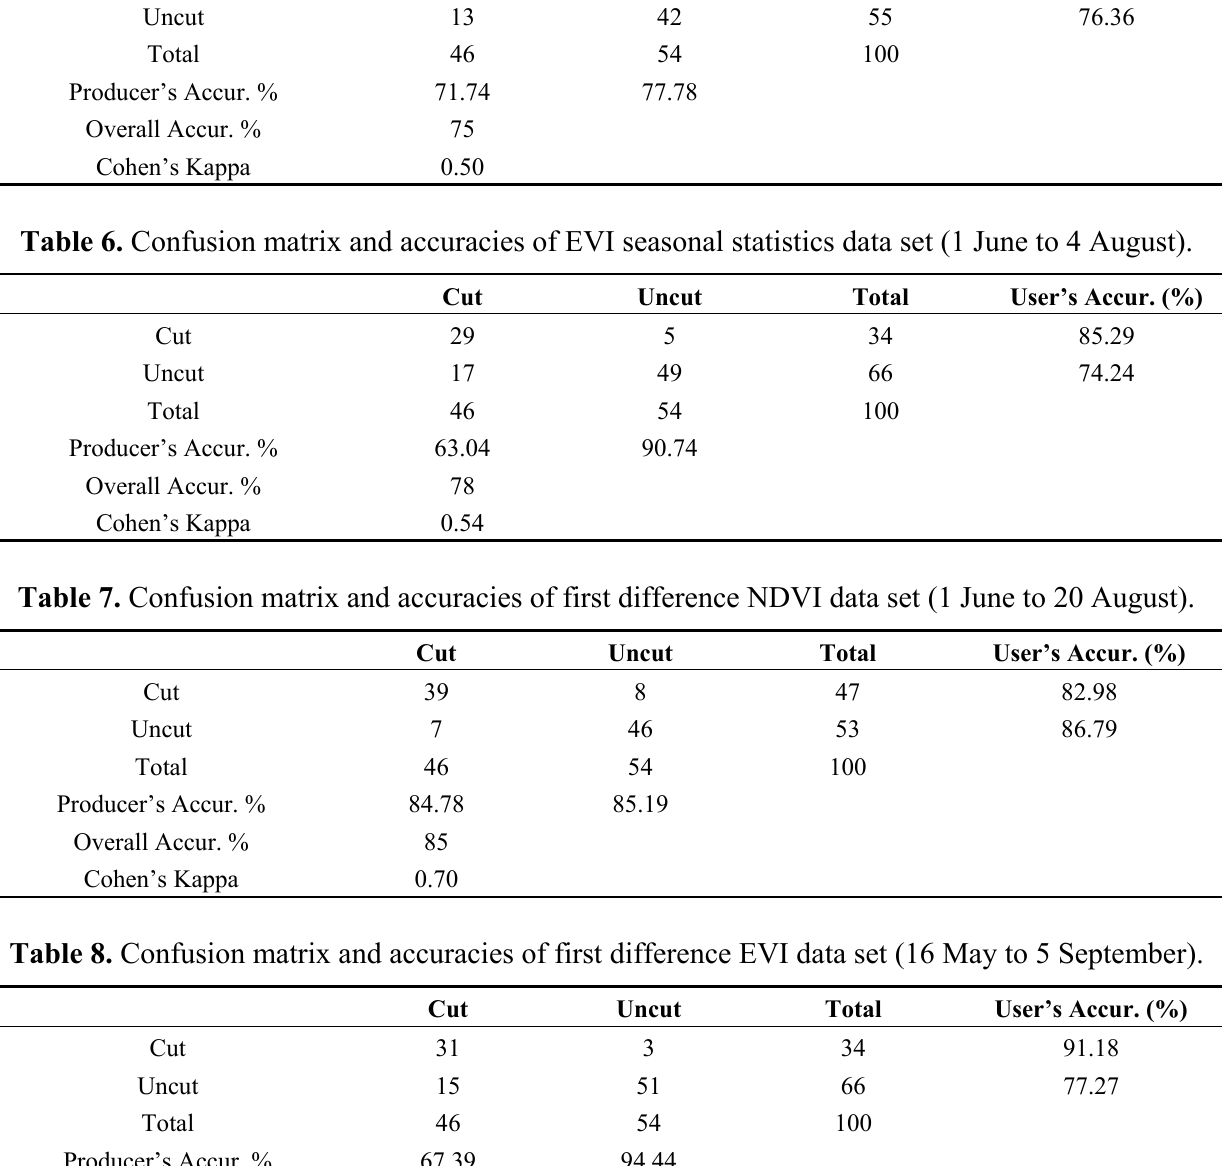
Producer’s Accur. %